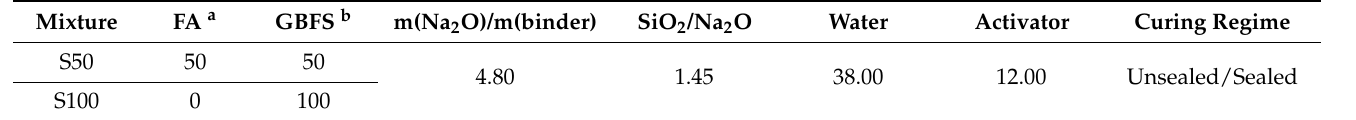
Table 2. Mixture design for pastes with respect to 100 g of